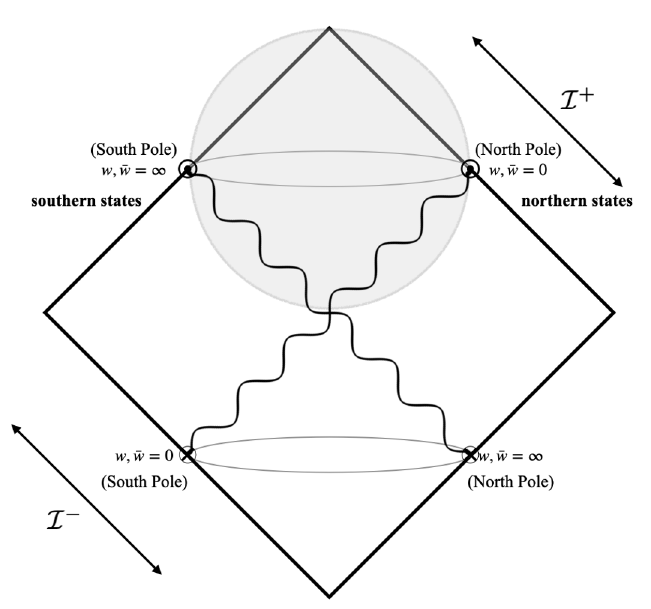
Figure 1 . “Northern” states enter in the southern hemisphere on I − and exit in the northern one on I + . “Southern” states enter in the northern hemisphere on I − and exit in the southern one on I + . Due to the antipodal identification between the angular coordinates at I + and I − , a free massless particle will enter and exit at the same point on the celestial